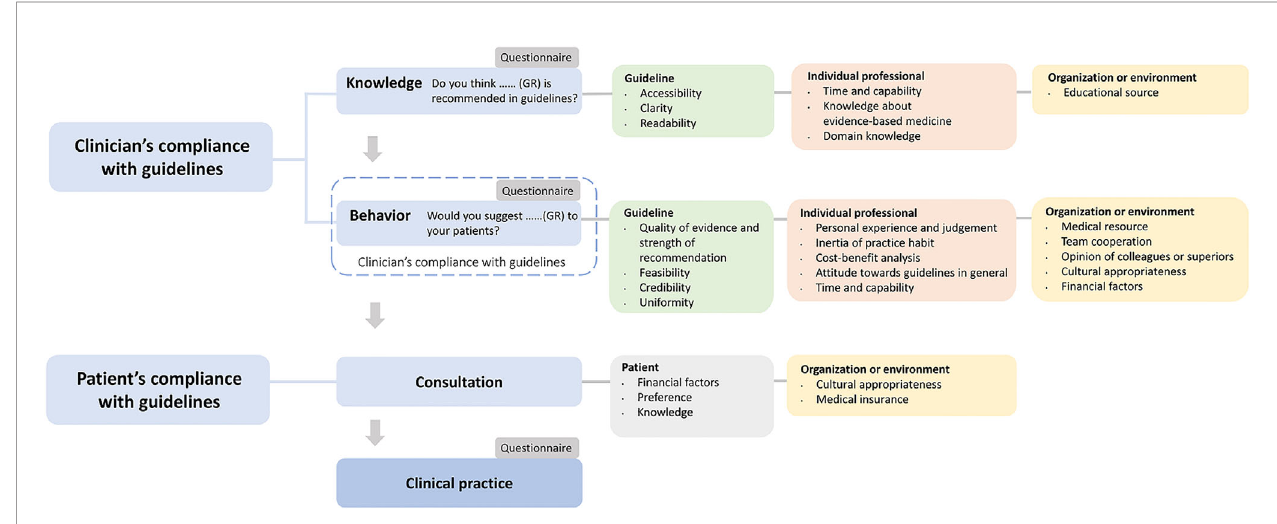
FIGURE 1 | Sequence of clinician ’ s compliance and associated